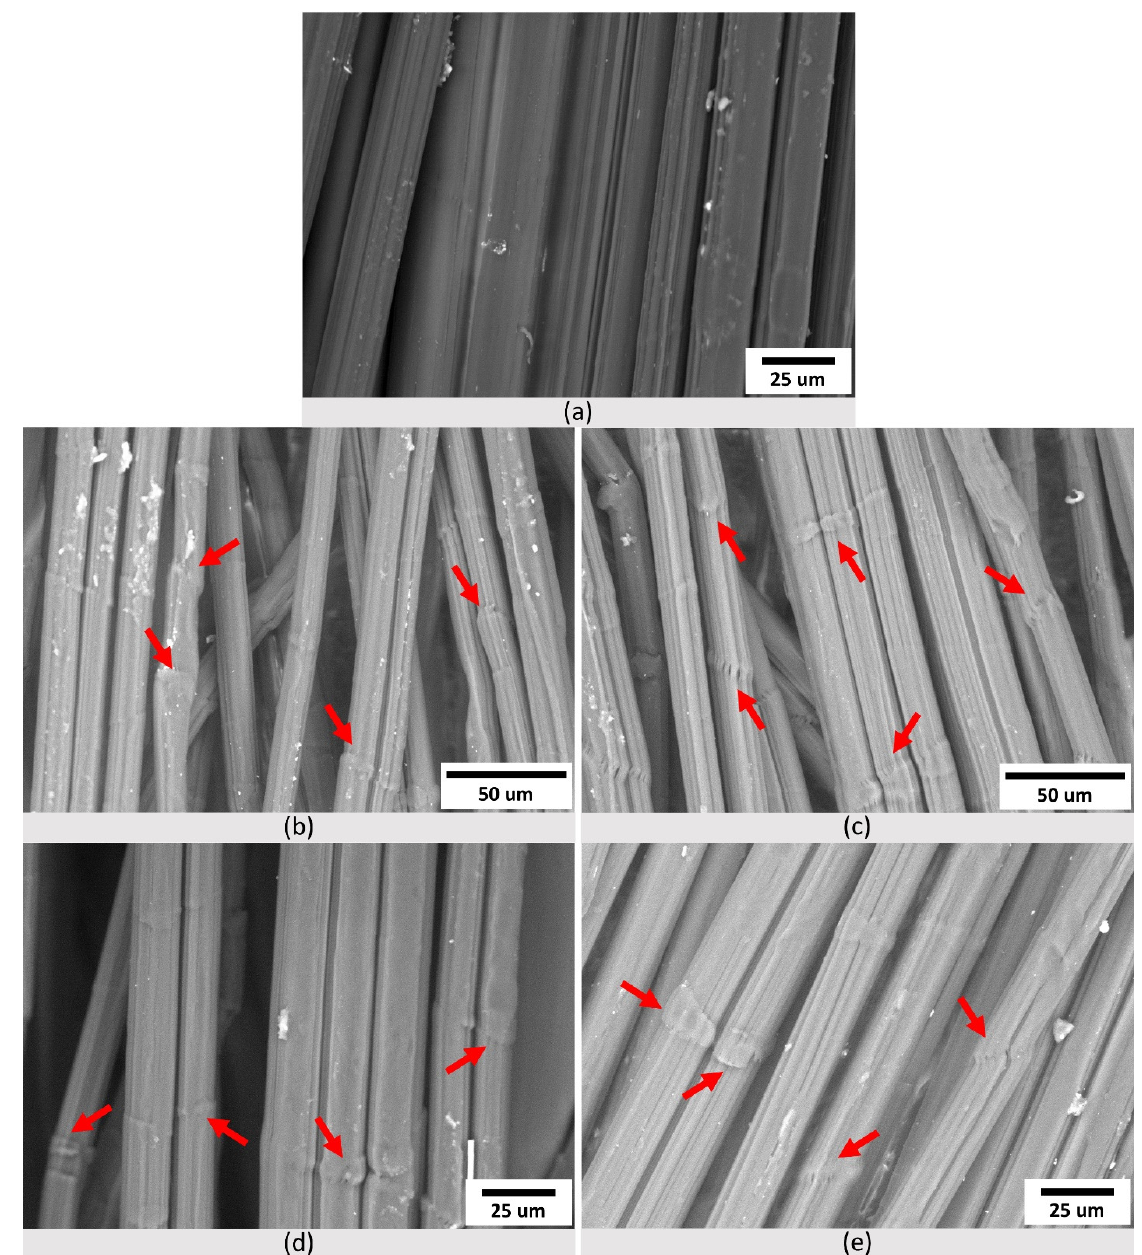
Figure 4. Scanning electron microscopy (SEM) micrographs of ( a ) control, and thermally aged